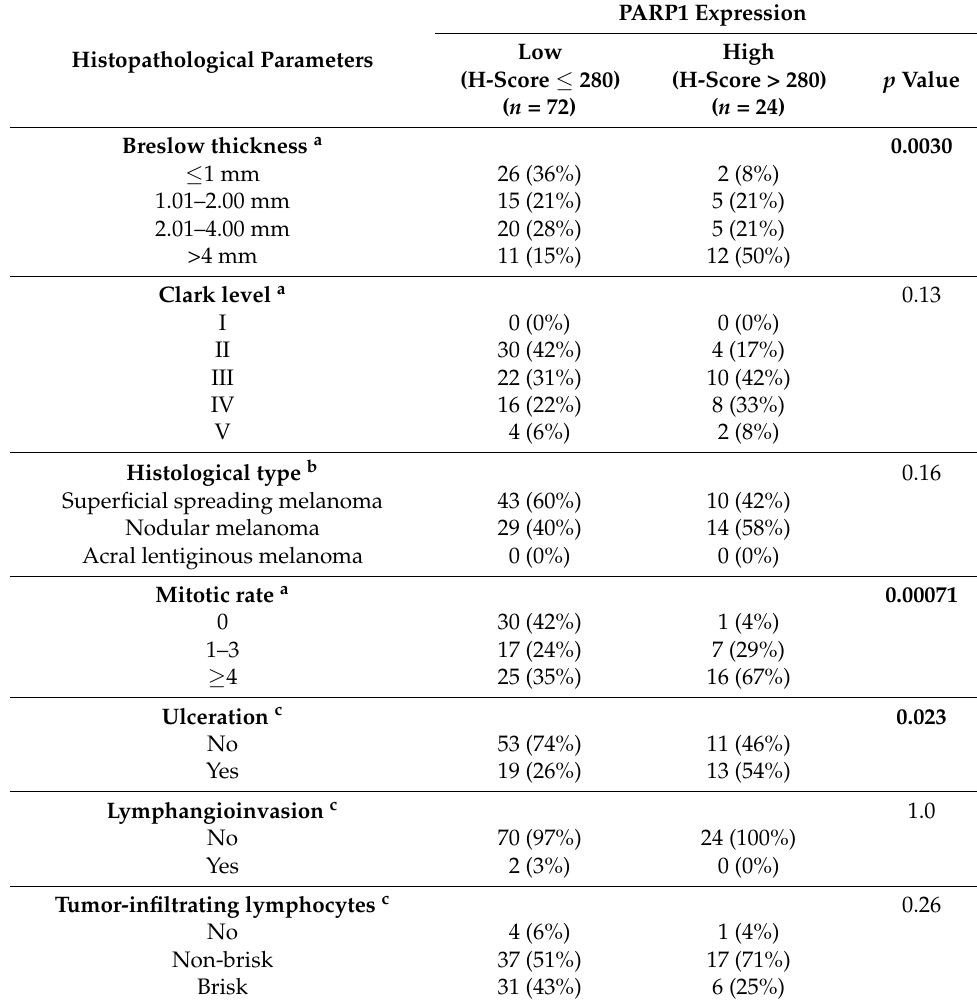
Table 5. Correlations between PARP1 expression and histopathological parameters of primary tumors in cutaneous melanoma patients without lymph node